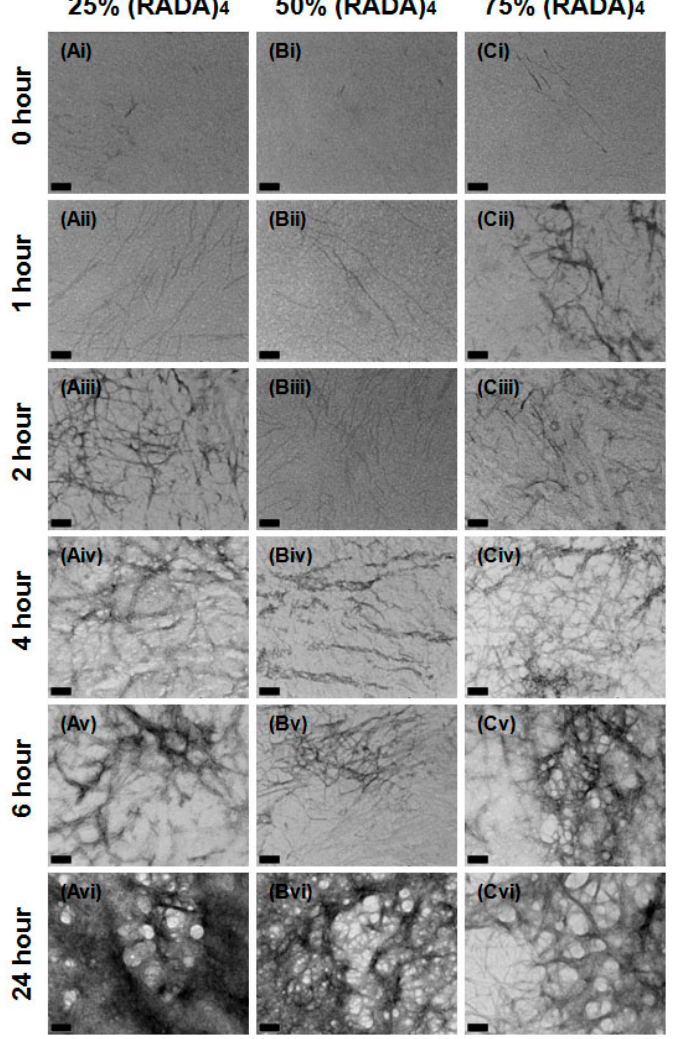
Figure 5. Transmission electron micrographs of ( A ) 25%/75%, ( B ) 50%/50%, and ( C ) 75%/25% (RADA)-GG-GPQG+PAGQ/(RADA) 4 at ( i ) 0, ( ii ) 1, ( iii ) 2, ( iv ) 4, ( v ) 6, ( vi ) 24 h. All samples were stained with 4% uranyl acetate and imaged at 0.5% w / v in TNC buffer upon 30 min of sonication and incubation at 37 °C. Scale bars are all 100 nm.